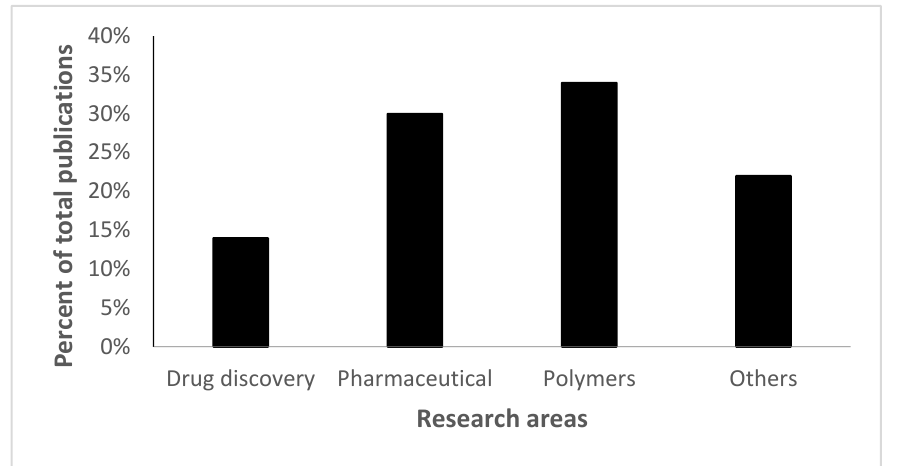
Figure 2. Click chemistry applications fall into four different categories; polymers (34%) represent the highest percentage while drug delivery represents the lowest (14%). The figure has been reproduced from another article [12] under a CC − BY license.